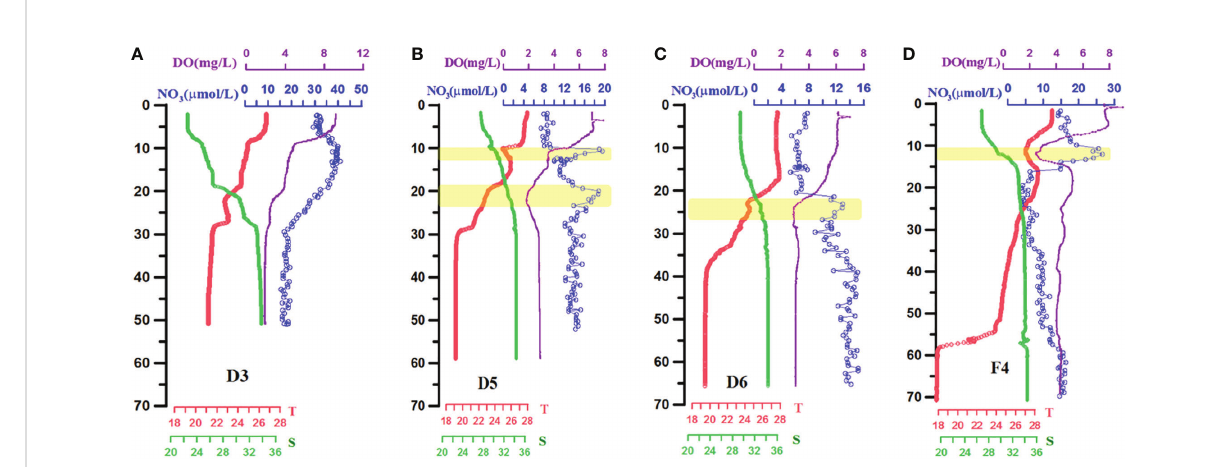
FIGURE 8 High-resolution depth pro fi les of temperature, salinity, DO, and nitrate (ISUS) in four stations: (A) D3; (B) D5; (C) D6; and (D) F4. Red solid line represents temperature, green is salinity, purple is DO, and the blue dotted line is NO − 3